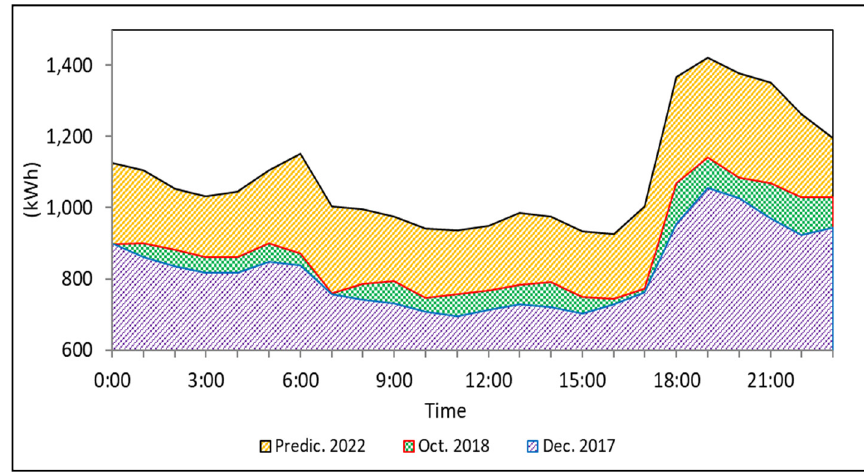
Figure 8. Forecasting the daily electricity demand in 2022.